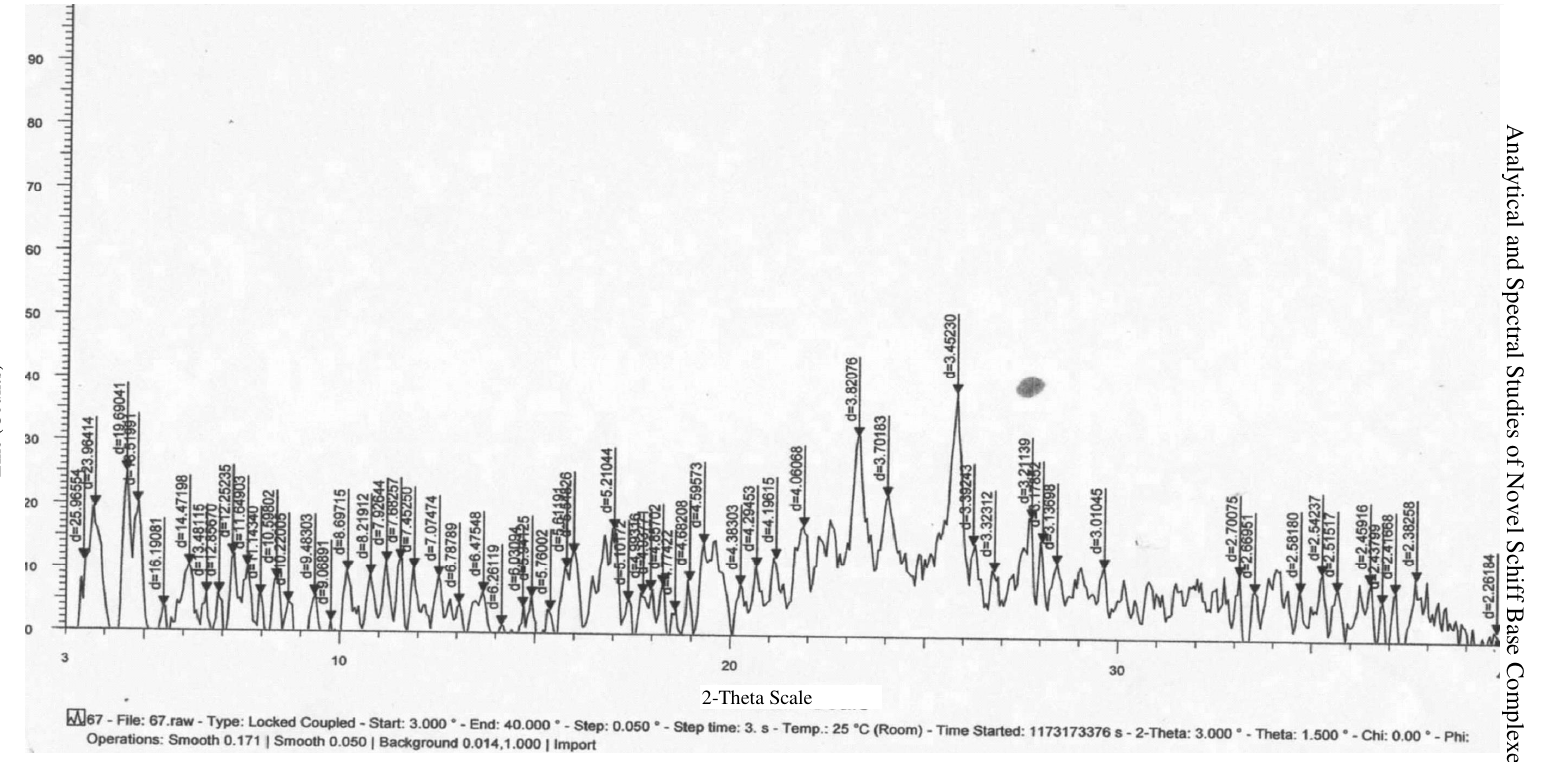
Figure 2 . X-Ray diffraction for [Th(2-FAPy)